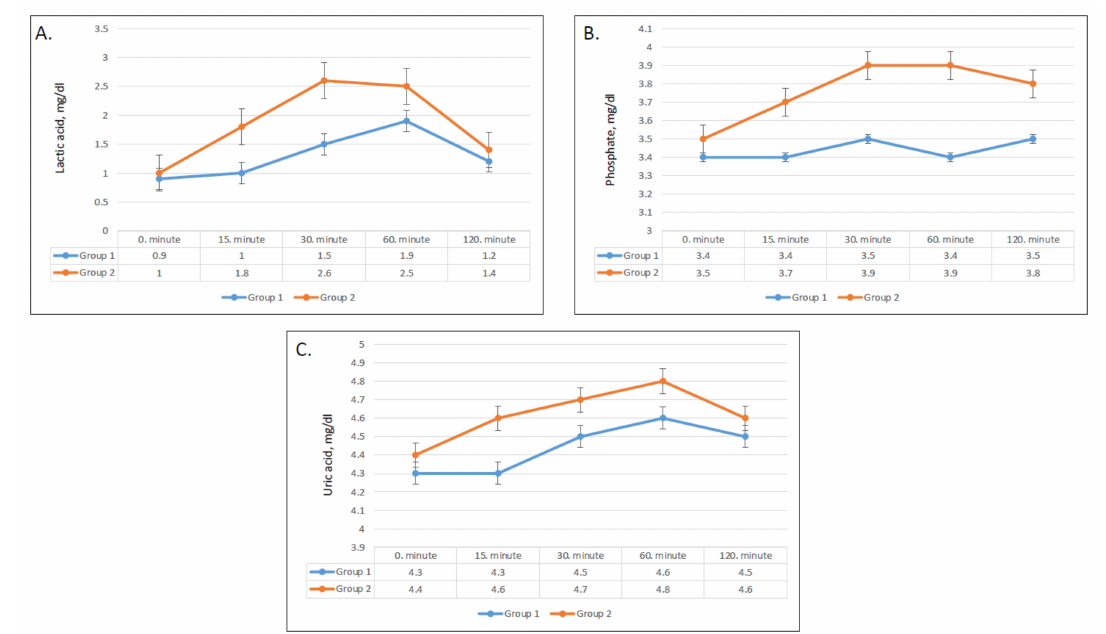
Figure 4. Changes in plasma lactic acid ( A ), plasma uric acid ( B ), and phosphate ( C ) values in group 1 and group